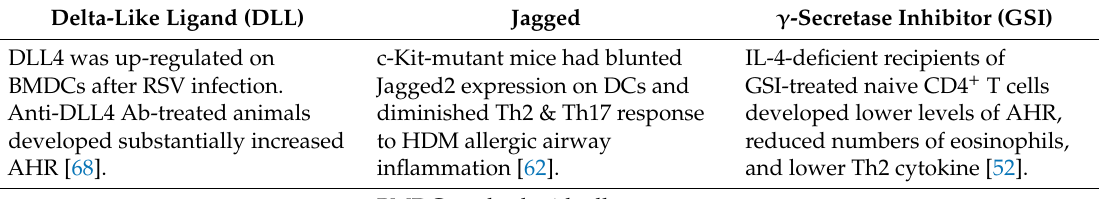
Table 1. Harnessing Notch signaling in animal models of allergic airway